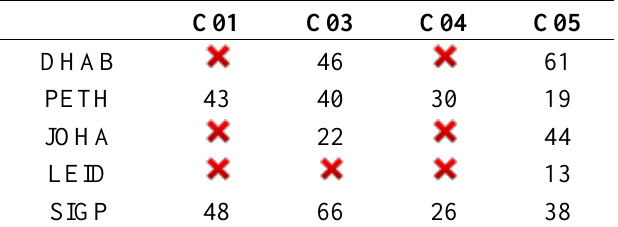
Table 7. GEOs elevation (in degrees) for tracking stations. Red cross for not